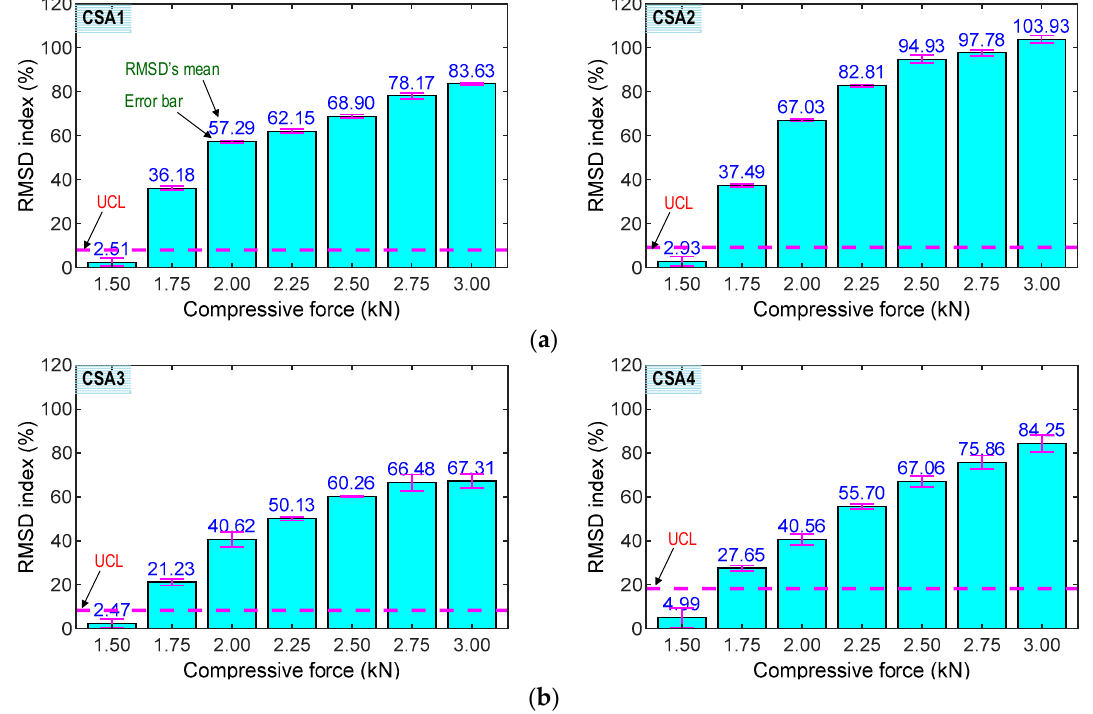
Figure 16. RMSD indices of CSAs under compression. ( a ) z-directional loading. ( b ) x-directional loading.